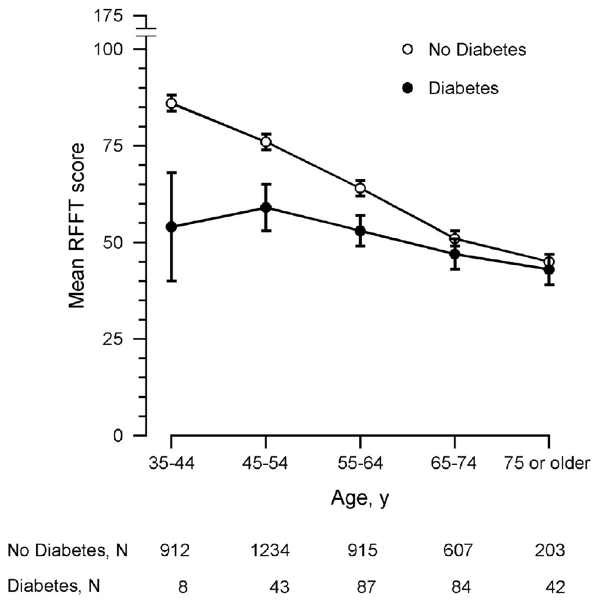
Figure 1. RFFT score dependent on age and the presence of type 2 diabetes. For clarity, data are presented as mean and 95% confidence interval in ten year age groups (data unadjusted for possible confounders). Abbreviation: RFFT, Ruff Figural Fluency Test.